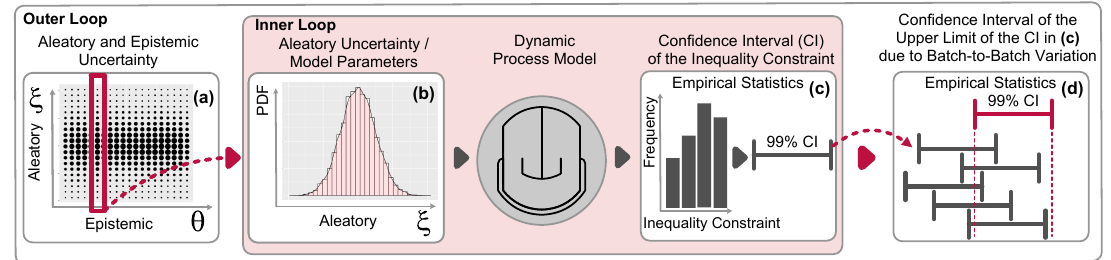
Figure 2. Illustration of the outer and inner loop setting for evaluating the inequality constraint under aleatory and epistemic uncertainty. Sampling from epistemic uncertainty ( a ) results in aleatory uncertainty realization ( b ), which is propagated to the inequality constraint ( c ) via the process model. Re-sampling from the epistemic uncertainty ( a ) helps to quantify the variation in the upper limit of the inequality constraint ( d